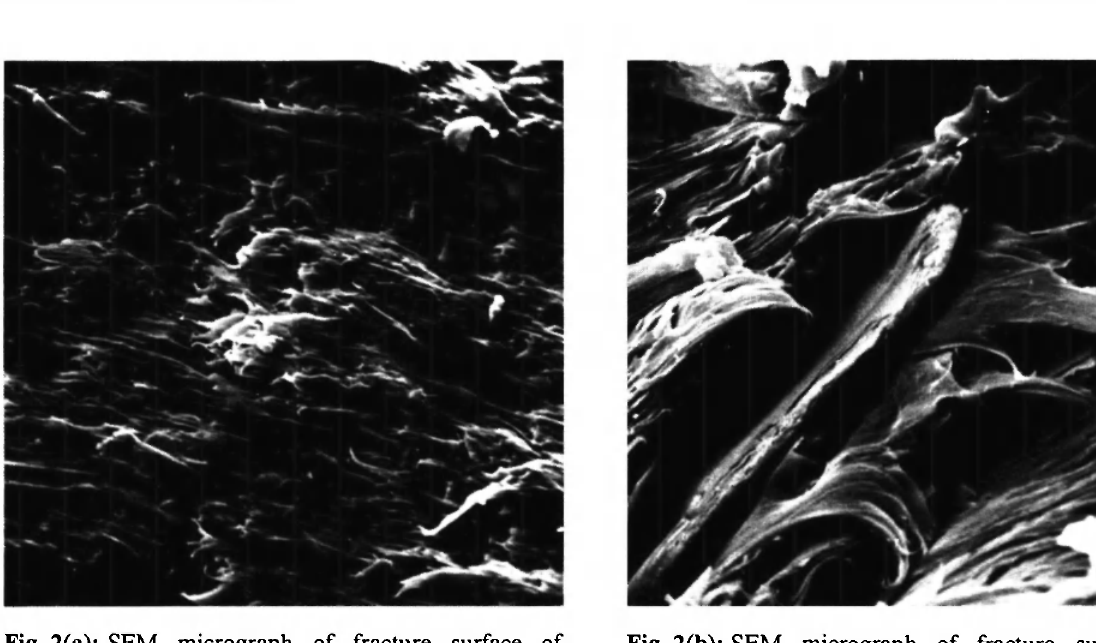
Fig. 2(a): SEM micrograph of fracture surface of MPP/[CaCC >3 /phlogopite] composite with strong matrix-filler adhesion (0.7 wt% ΜΑΗ). Initial flake size of 20 μπι did not change substantially after mixing. The surface was prepared by fracturing a 4x6x50 mm 3 specimen containing sharp notch in impact. CaCC^/mica ratio was 1/3. Magnification 1200 times.